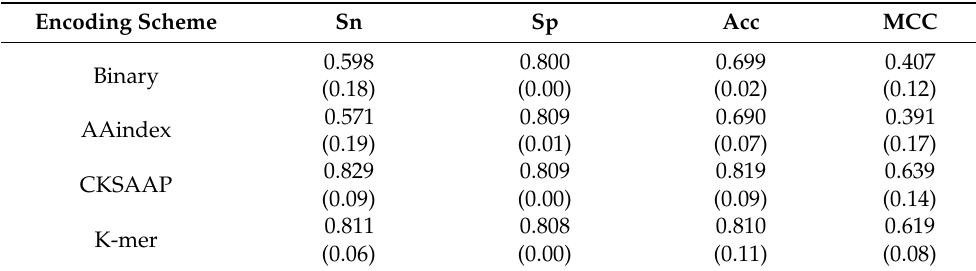
Table 2. Prediction performance of the single encoding-employing models with feature selection on the training dataset by five-fold CV.